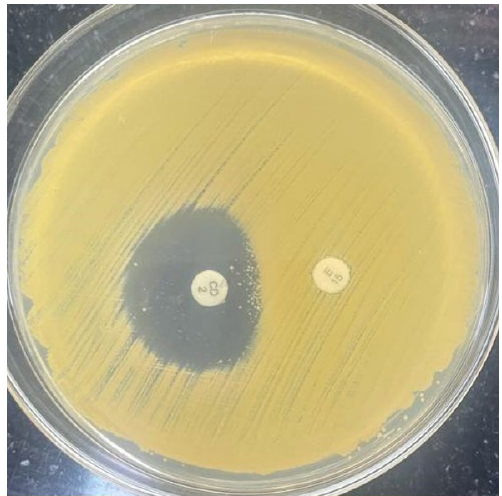
Fig. 1. D-Test. No zone of inhibition around erythromycin disc but zone of inhibition is present around clindamycin with flattening towards erythromycin giving the shape of